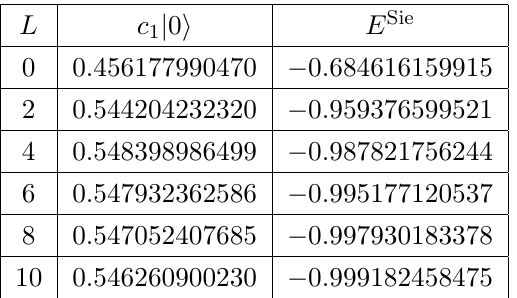
Table 1 . ( L; 3 L ) level-truncation results for the tachyon vev and vacuum energy in Siegel gauge.